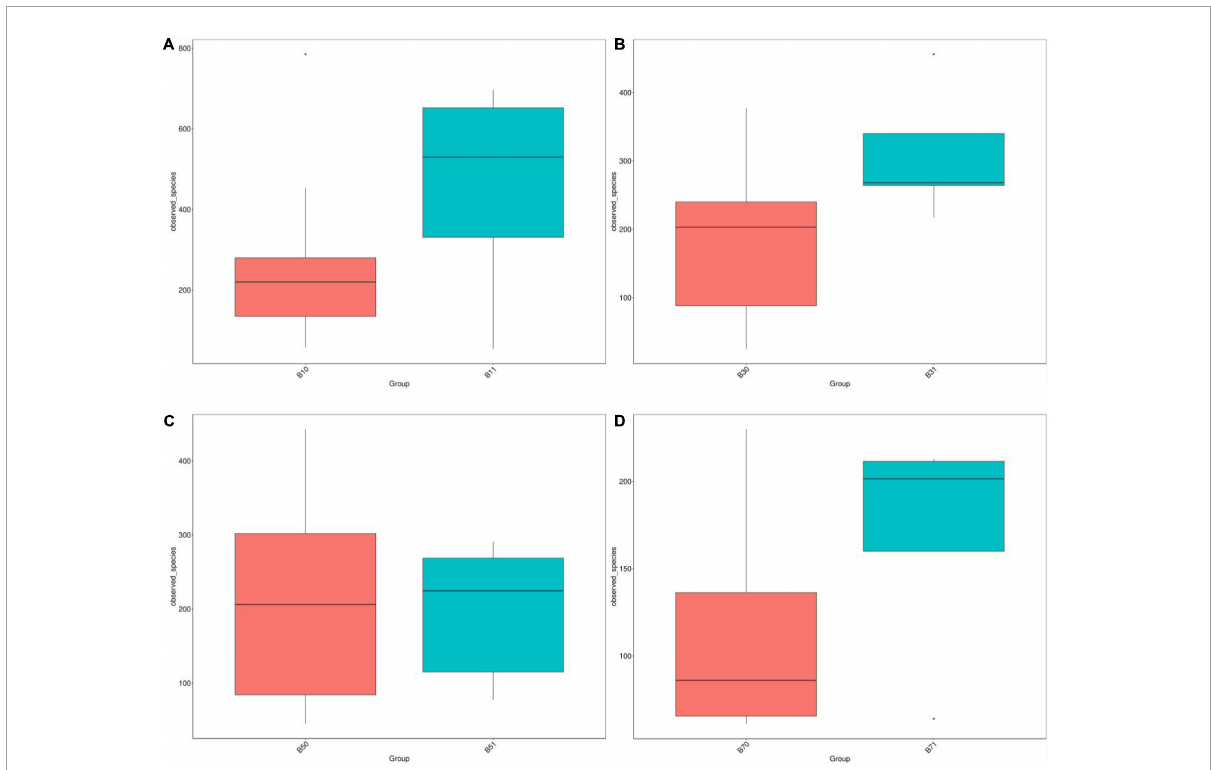
FIGURE4 Distribution box plots of alpha diversity index between the good and poor communication score groups on days 1, 3, 5, and 7. (A) Distribution box plots of the alpha diversity index on day 1. (B) Distribution box plots of alpha diversity index on day 3. (C) Distribution box plots of alpha diversity index on day 5. (D) Distribution box plots of alpha diversity index on day 7. B11, gut microbiota of the poor communication score group on day 1; B10, gut microbiota of the good communication score group on day 1; B31, gut microbiota of the poor communication score group on day 3; B30, gut microbiota of the good communication score group on day 3; B51, gut microbiota of the poor communication score group on day 5; B50, gut microbiota of the good communication score group on day 5; B71, gut microbiota of the poor communication score group on day 7; B70, gut microbiota of the good communication score group on day